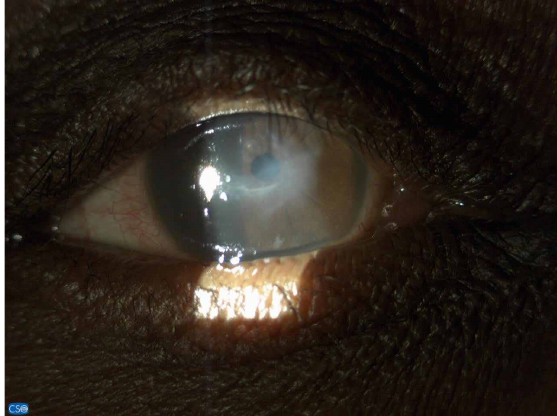
Figure 4 . An example of scarring associated with keratoconus